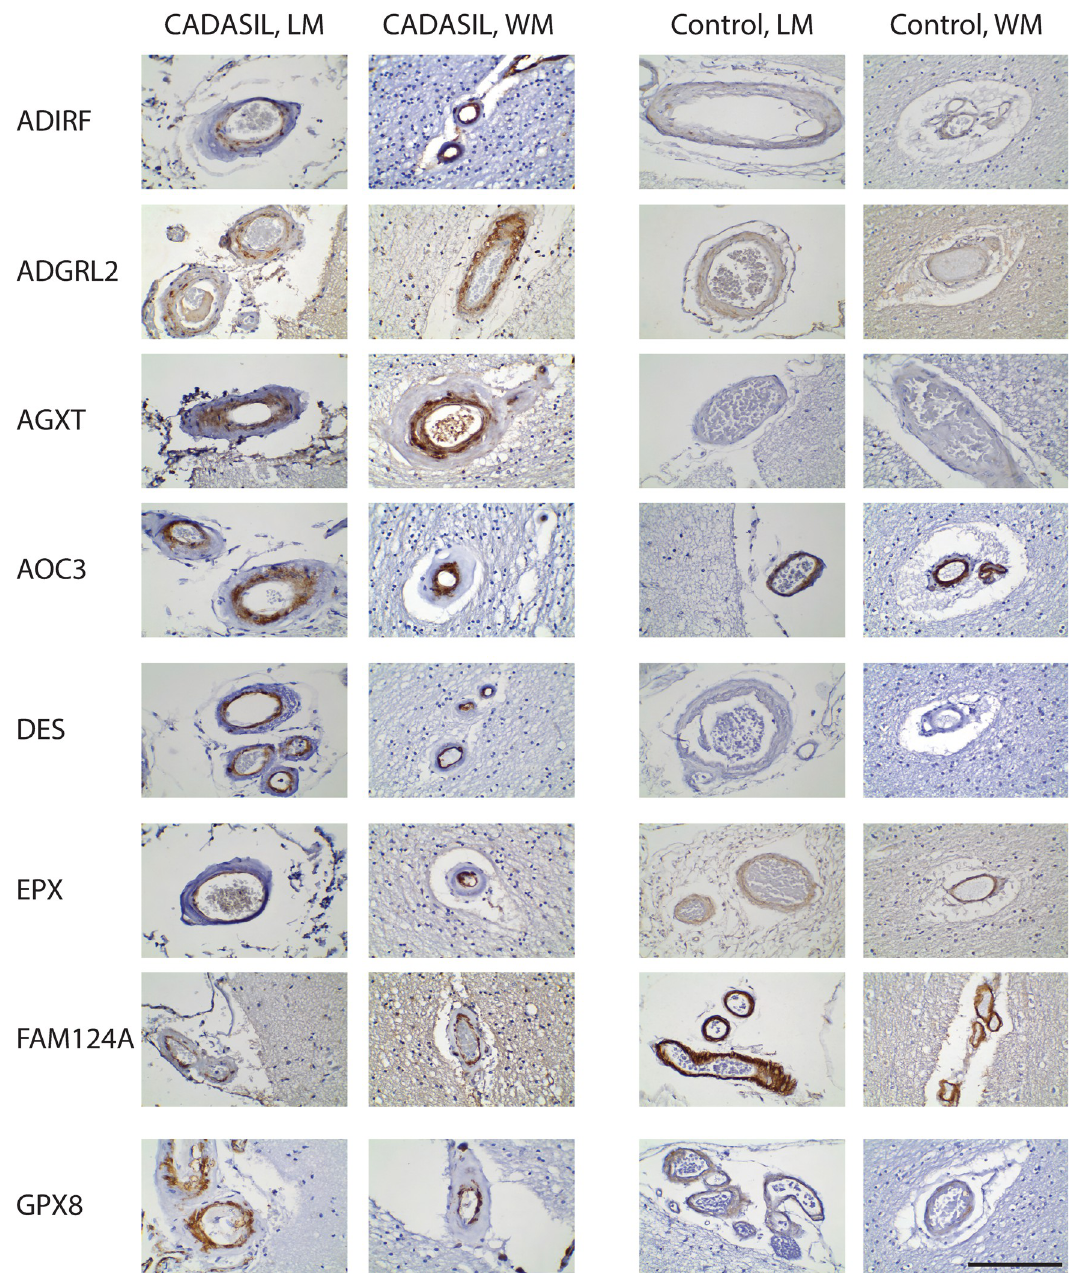
Fig 2. Vascular smooth muscle cell proteins in CADASIL and control arteries. Eight antibodies (labeled on the left) were used for immunohistochemical localization of respective smooth muscle antigens in CADASIL and control brains. Both leptomeningeal (LM) and white matter (WM) vessels are shown to illustrate representative positively-stained vessels. Scale bar shows 100 microns.